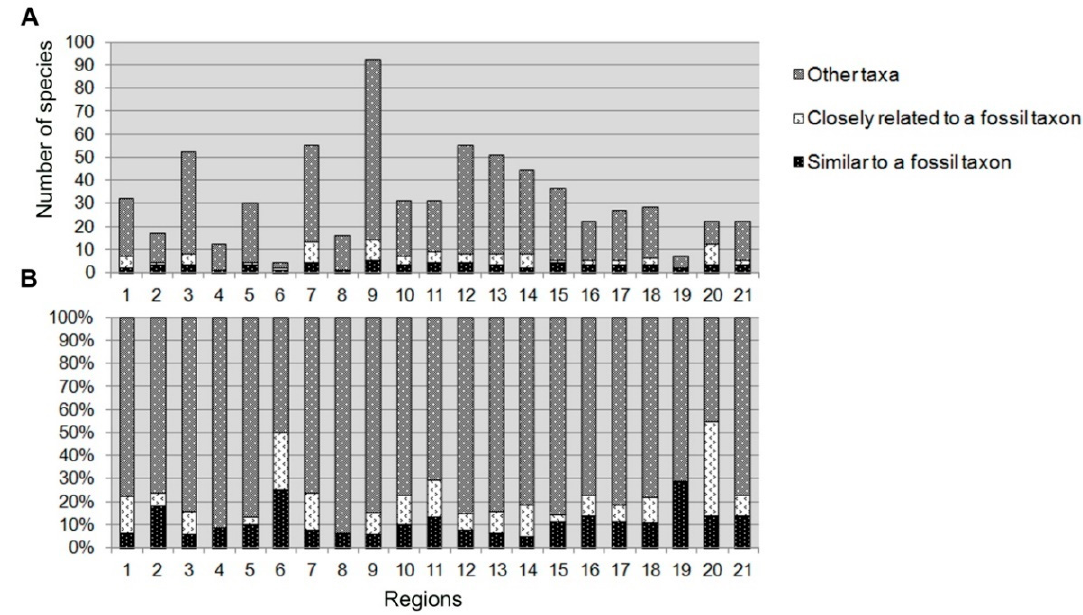
Figure 4. Number of species to a fossil taxon, species closely related to the fossil taxa (to Siver et al., 2013; 2015) [25,26], and other species of silica-scaled chrysophytes in the analyzed regions. The numbers of the regions correspond to those given in Figure 2 and Table 1; data on species occurrence are given in the references in Table 1. ( A ) Number of species; ( B ) Percentage of